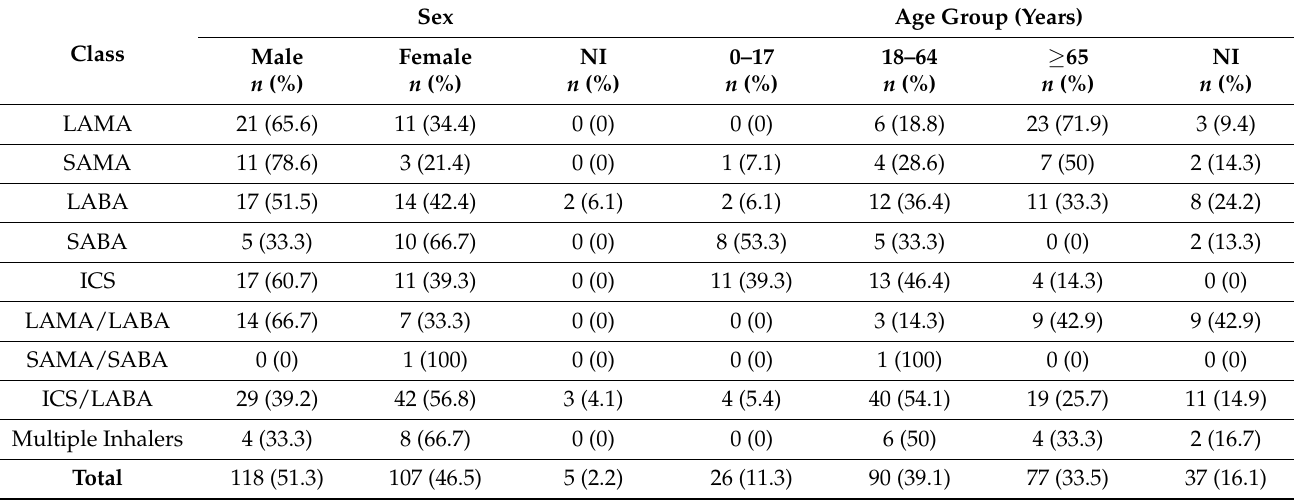
Table 4. Demographic aspects of the Spontaneous Reports by pharmacological